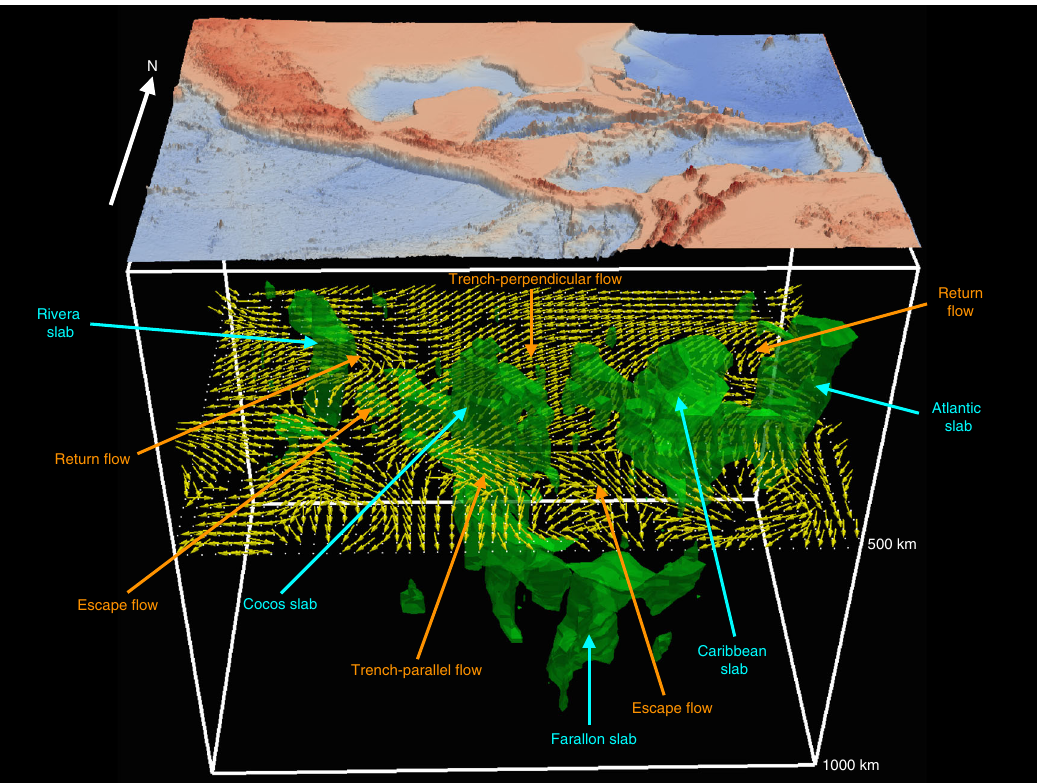
Fig. 7 3-D iso-surface representations of fast wavespeed anomalies with magnitude >1.5% (green bodies), and fast axes (yellow arrows) at a depth of 500 km in model US 32 . Topographic variations are superimposed on top of the 3-D iso-surface bodies. Fast anomalies shallower than 250 km, mainly the North and South American lithospheres, are clipped for better visualization of sinking slabs. Cyan arrows are used to highlight slab features, whereas orange arrows are used to denote mantle fl ow fi elds.